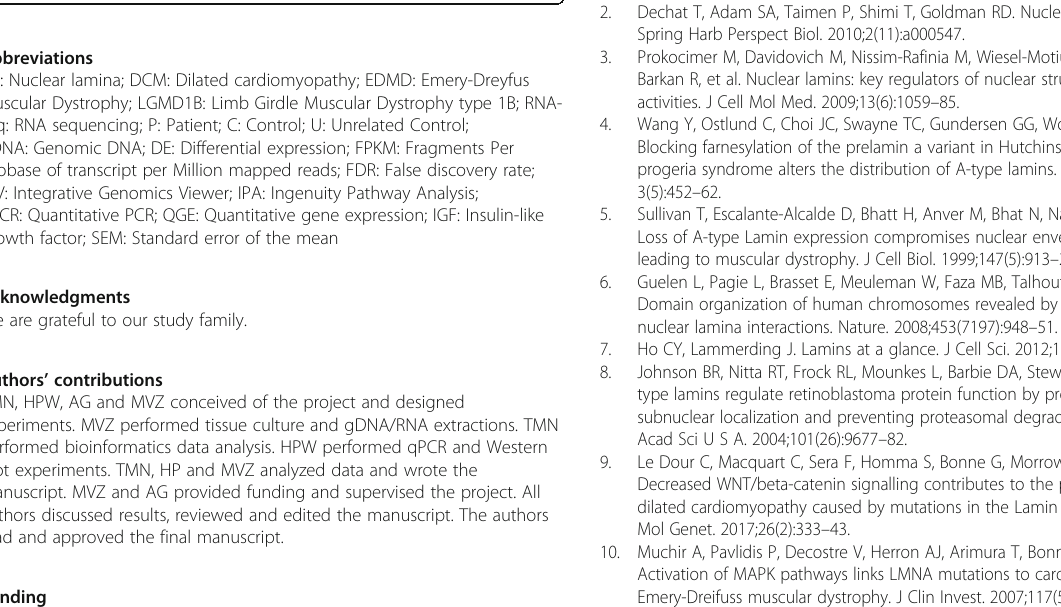
Additional file 1: Table S1 . Sequencing statistics. Table S2 . qPCR primer sequences. Table S3 . RNA-seq expression values for LMNA , LMNC , and IGFBP5. Additional file 2: Figure S1 . IGV screenshots showing expression of LMNA transcripts at exons 1, 2 and 3. Figure S2 . Lamin B1 and Lamin B2 heatmap and qPCR validation. Figure S3 . Original Lamin A/C Western